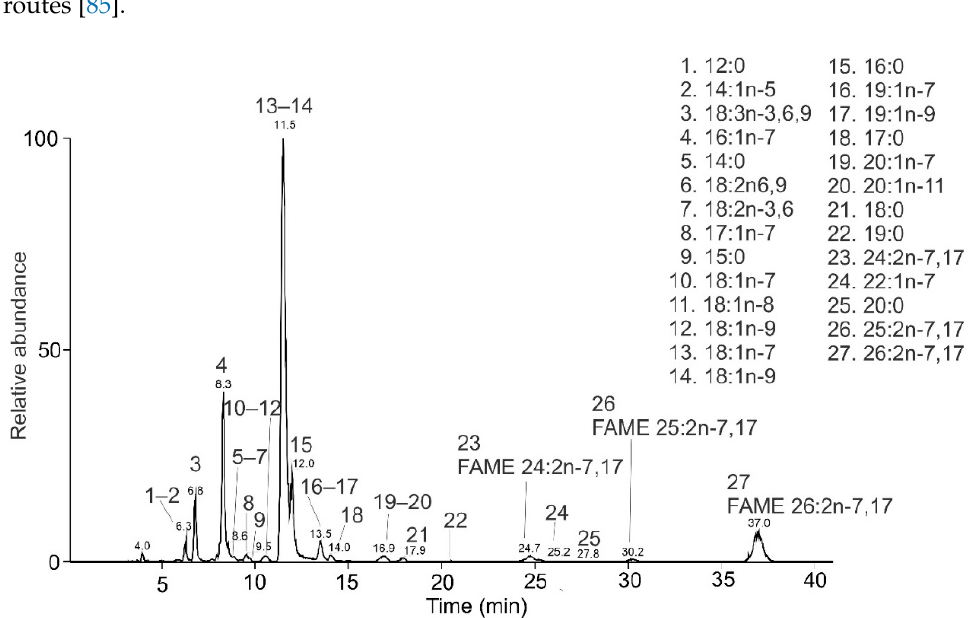
Figure 4. APCI MS/MS CID spectrum of the [M + 55] +• adduct of crepenynic acid methyl ester